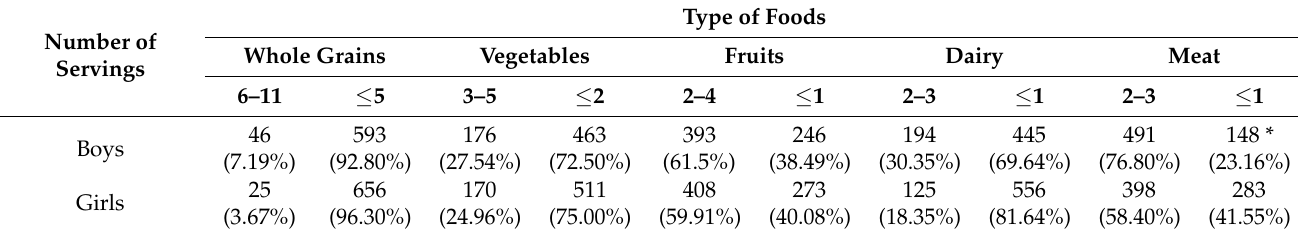
Table 3. Food group intake in the lot